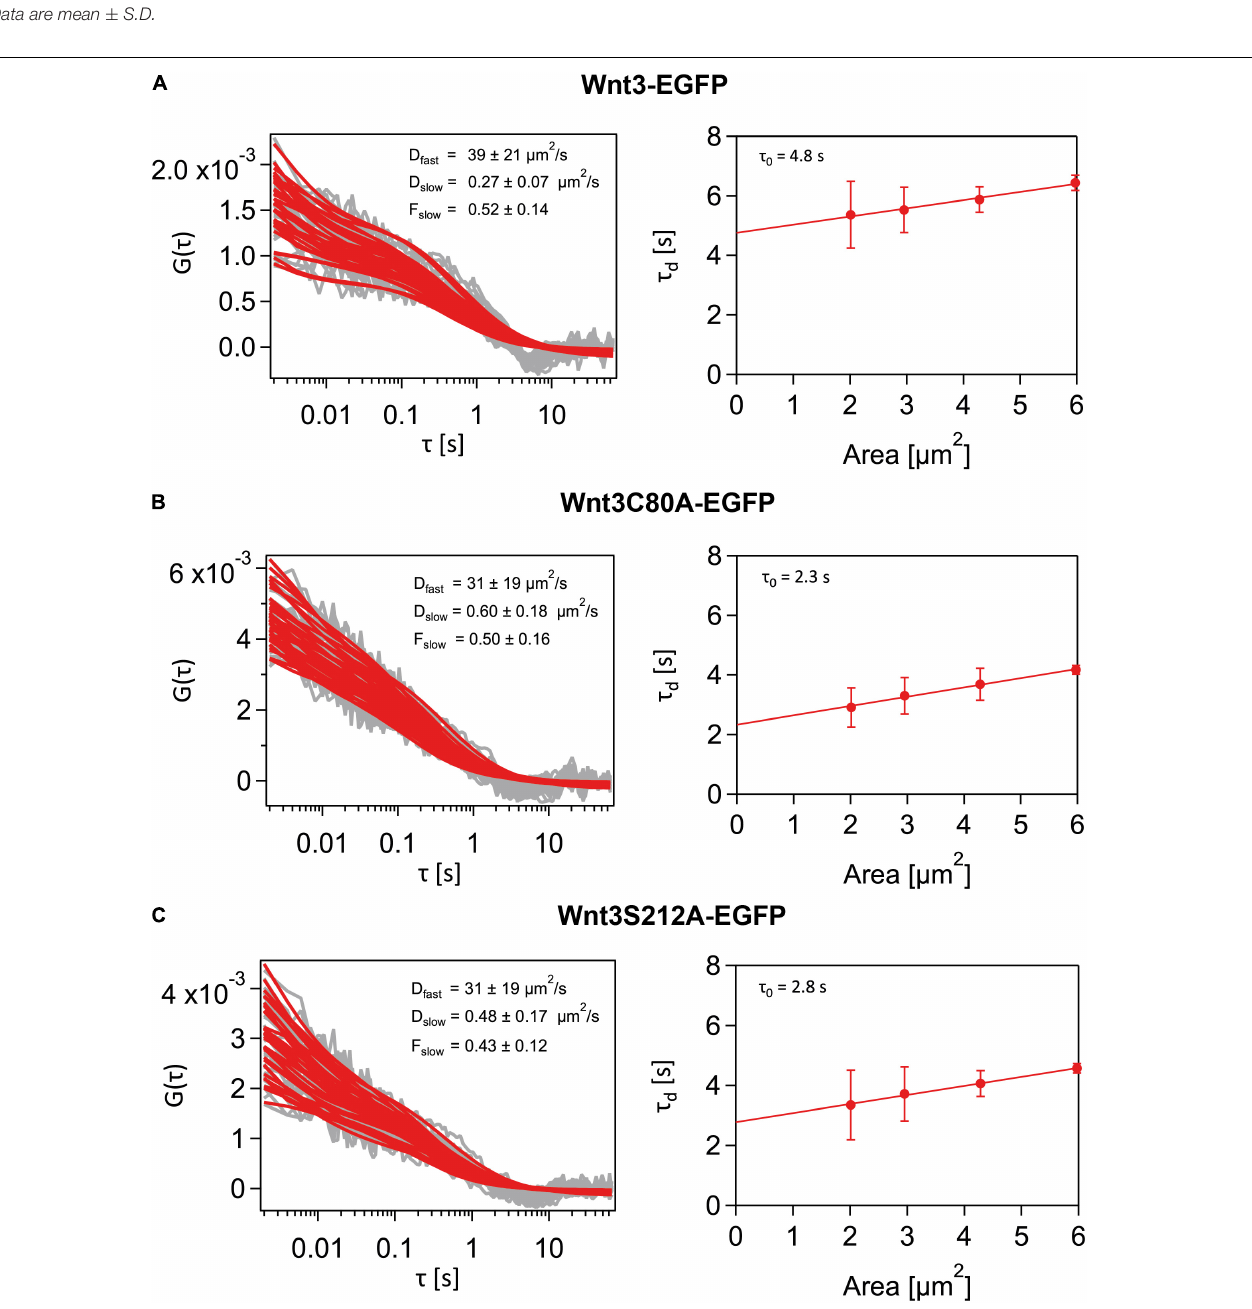
FIGURE 7 | Representative SPIM-FCS and Diffusion law data from a cell. (A) Autocorrelation functions (left) and Diffusion law plot (right) for a Wnt3-EGFP expressing cell in vivo. Wnt3-EGFP expressing cells have higher τ 0 value than the mutants. (B) Autocorrelation functions (left) and Diffusion law plot (right) for a Wnt3C80A-EGFP mutant-expressing cell in vivo. (C) Autocorrelation functions (left) and Diffusion law plot (right) for a Wnt3S212-EGFP mutant expressing cell in vivo. All autocorrelation function plots have the raw correlation data in gray and their corresponding fit in red.